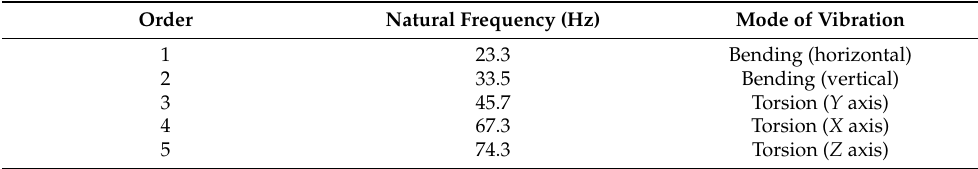
Table 2. The natural frequency and mode of the actual model.